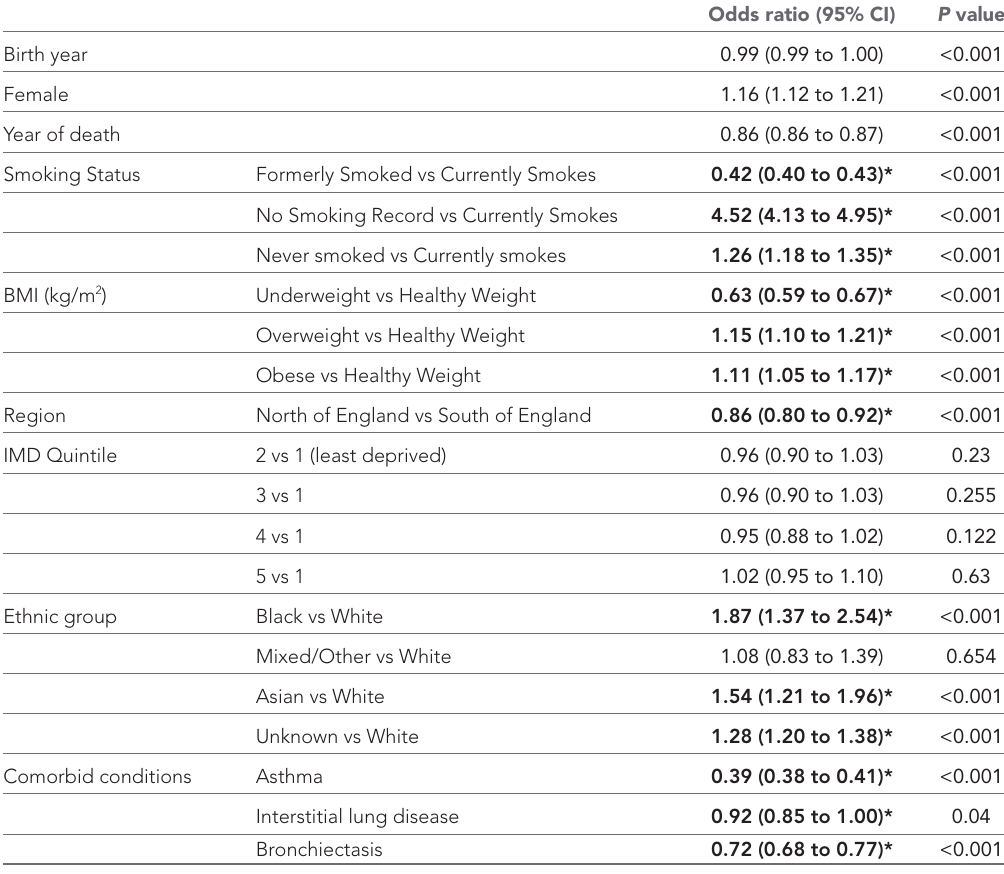
Table 2 Adjusted odds ratios for missed COPD diagnosis for all factors tested in the multiple regres- sion